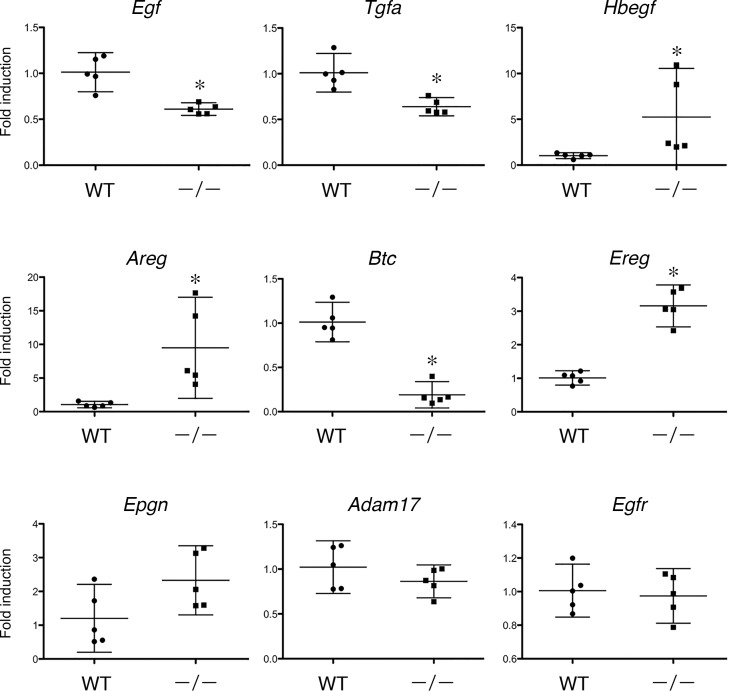
Gene expression of EGFR and its ligands in wild-type and in Tgm1–/–skin.Data were obtained from 5 independent specimens of Tgm1–/–epidermis (–/–) vs wild-type epidermis (WT) (19.5 dpc pups, n = 5), and fold-inductions of the mean values of expression in wild-type epidermis are plotted with means and bars representing 95% CI. *, P<0.01.